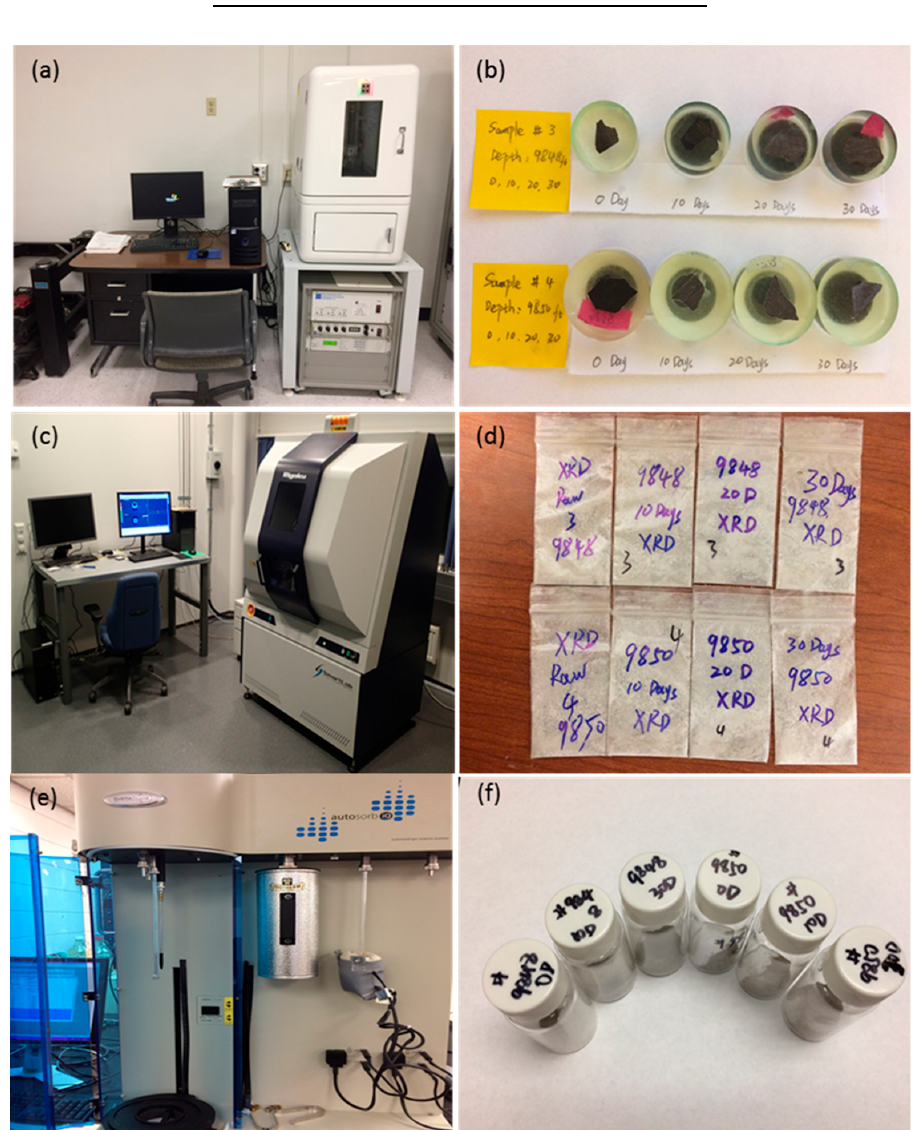
Figure 2. Analysis instruments and samples preparation for the miscellaneous test. ( a ) Nano-indenter; ( b ) Sample specimens for the nano-indentation test; ( c ) X-ray diffraction (XRD); ( d ) Samples for XRD; ( e ) Quantachrome Autosorb-IQ; ( f ) Sample powder for low-temperature N 2 adsorption.